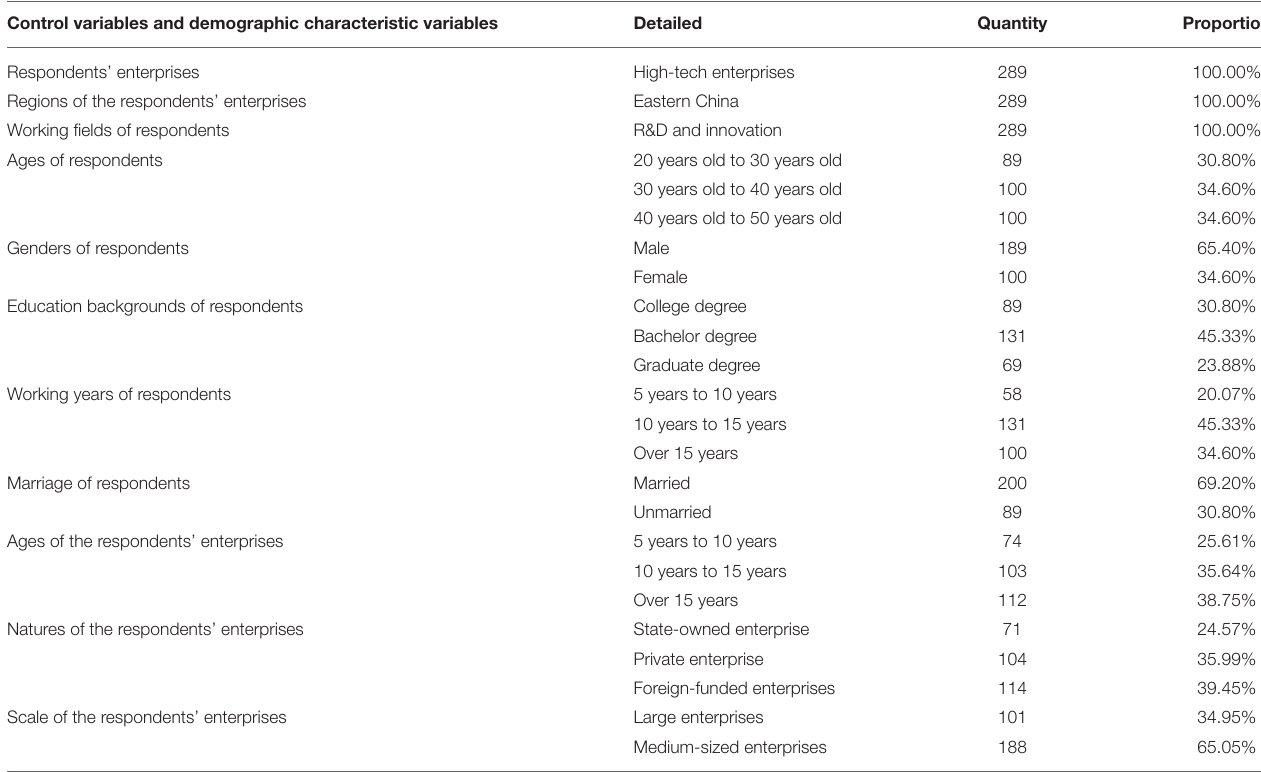
TABLE 1 | Statistical analysis results of questionnaire investigation data.